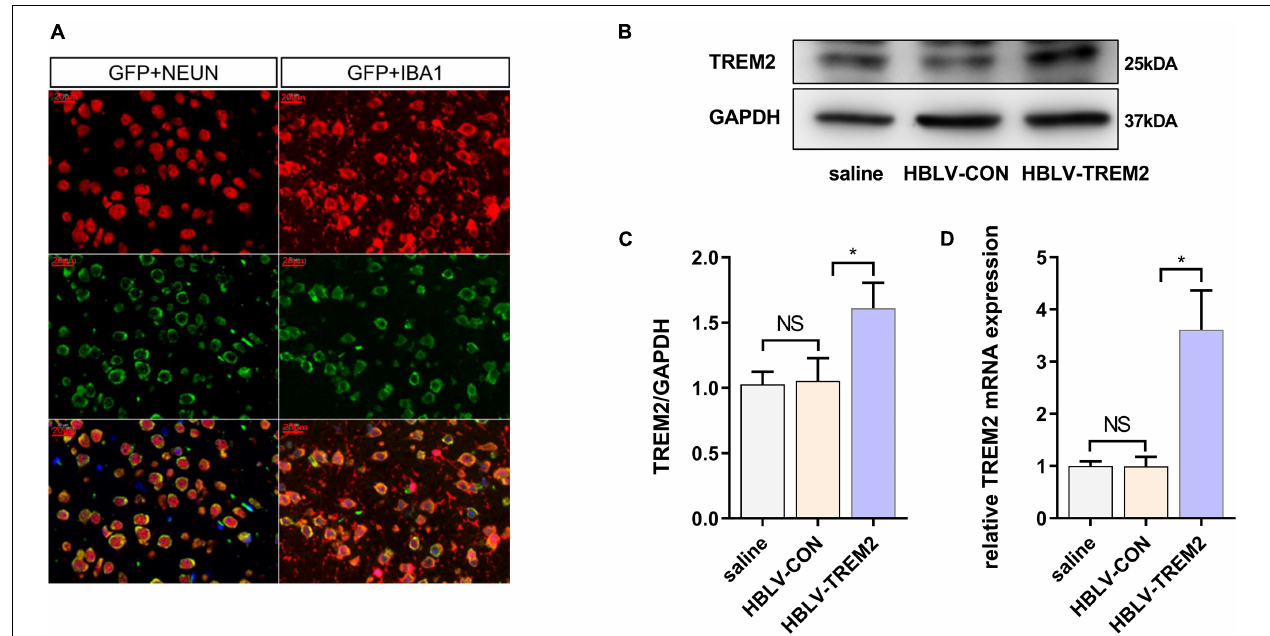
FIGURE 5 | HBLV-TREM2 was transferred into neurons and microglia, promoted the expression of TREM2 in SNpc. The mice were subjected to stereotactic intraventricular treatment with HBLV-TREM2. Then, the mice were decapitated, and the midbrain was obtained 7 days after the HBLV-TREM2 injection. (A) Immunofluorescence of GFP marker and Iba1 or Neun are shown ( n = 1/group). Red: anti-Iba1 (antibody labeling microglia) and NeuN (antibody labeling neurons). Green: GFP marker. Scale bar: 100 µ m and 20 µ m. (B) Seven days after injection of the HBLV-TREM2 or HBLV-NC, the TREM2 protein was detected by WB ( n = 3/group). (C) The expression level of TREM2 protein was analyzed by quantitative analysis of protein ( F = 12.66). (D) The mRNA expression level of TREM2 was detected by qPCR ( n = 3/group) ( F = 33.59). All the quantitative analysis of protein was done by Image J to calculate the gray value. Data are shown as the mean ± SE. The fold change is significant where * P < 0.05, ** P < 0.01. n = number of